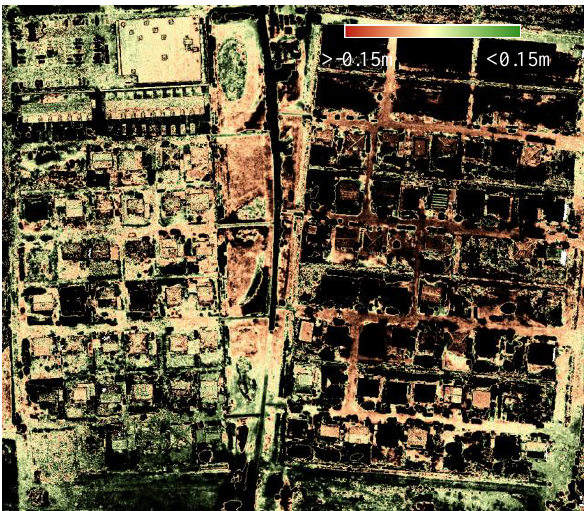
Figure 9: DSM difference between 2nd and 3rd epoch in centimetre range (-15cm to 15cm)